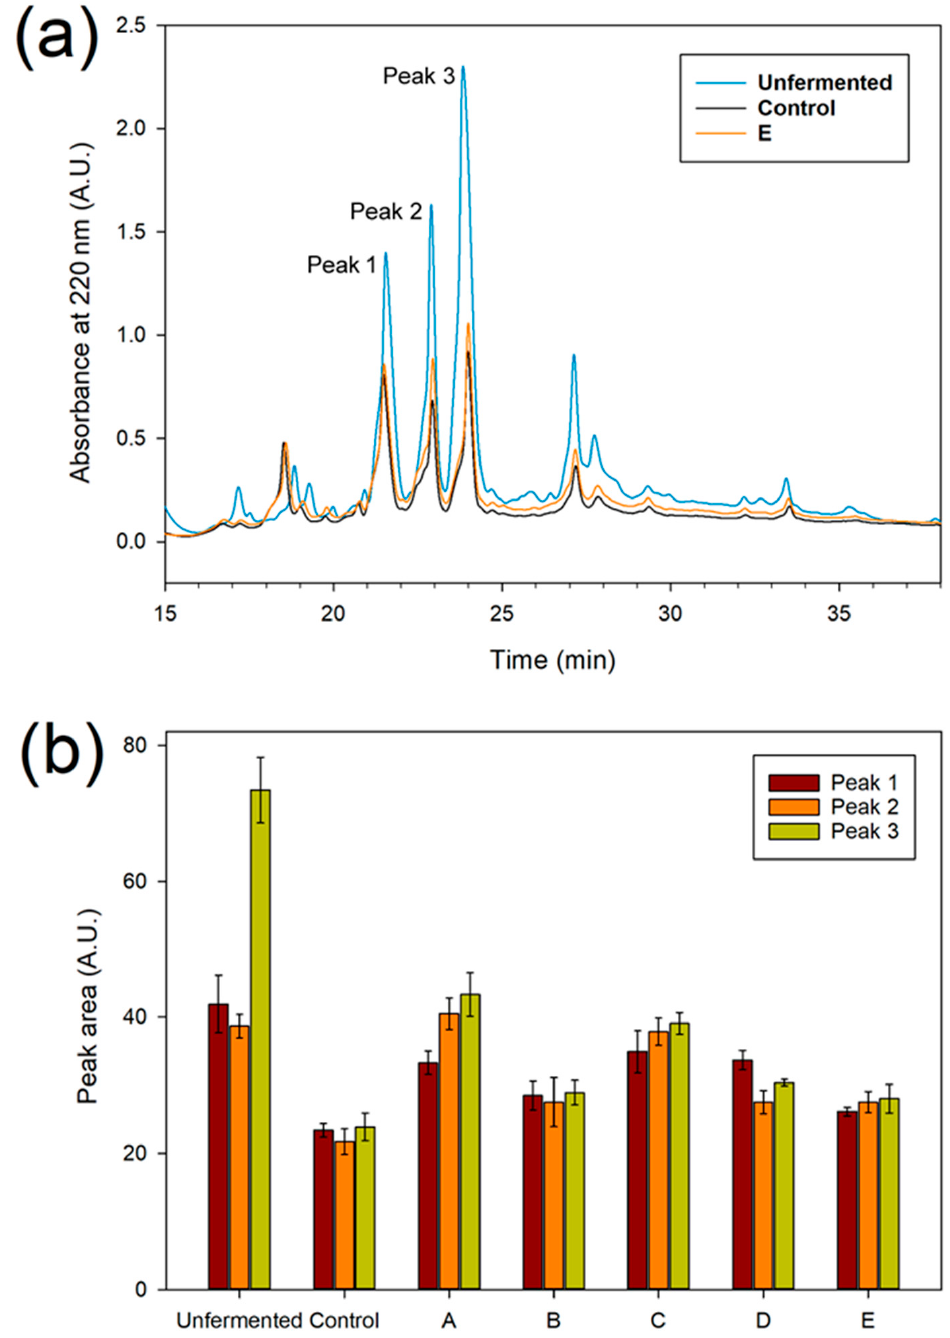
Figure 3. Peptide profile of unfermented and fermented samples. ( a ): RP-HPLC chromatograms of peptide extracted from cocoa beans. For the sake of comparison, only chromatograms from unfermented, control and co-culture at t 0 + t 48 have been reported. Chromatograms of all the samples are available in Figure S1. ( b ): Areas of the three main peaks observed in RP-HPLC chromatograms; unfermented: unfermented cocoa beans; control: spontaneous fermentation; A: inoculated with L. fabifermentans at t 0 ; B: inoculated with L. fabifermentans at t 0 and t 48 ; C: inoculated with F. rossiae at t 0 ; D: inoculated with F. rossiae at t 0 and t 48 ; E: inoculated with both strains at t 0 and t 48 .